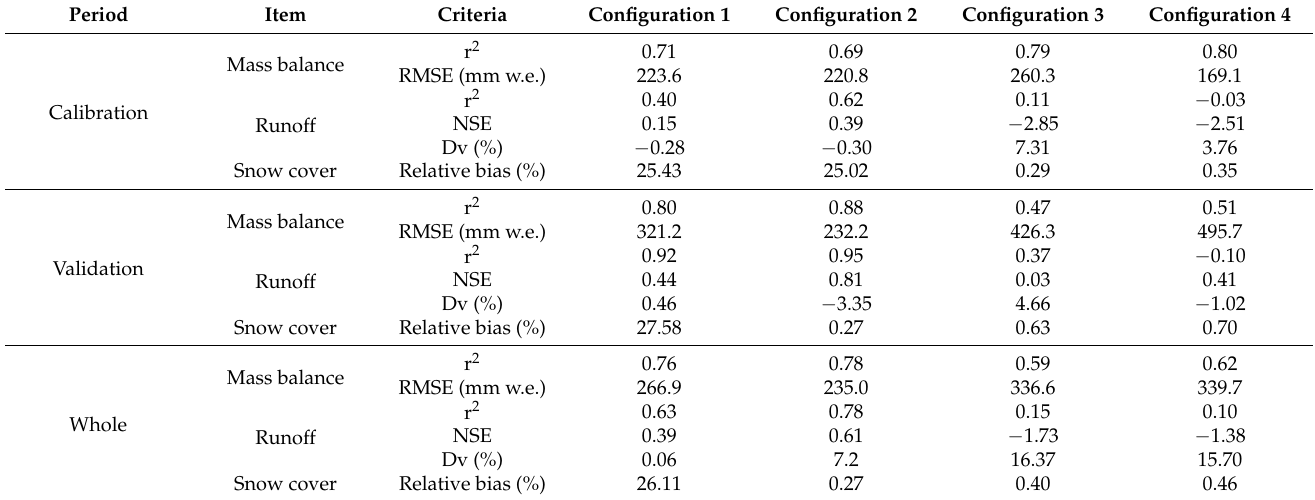
Table 3. Statistical results of model performance during model calibration, validation, and the whole period at the Tuole River